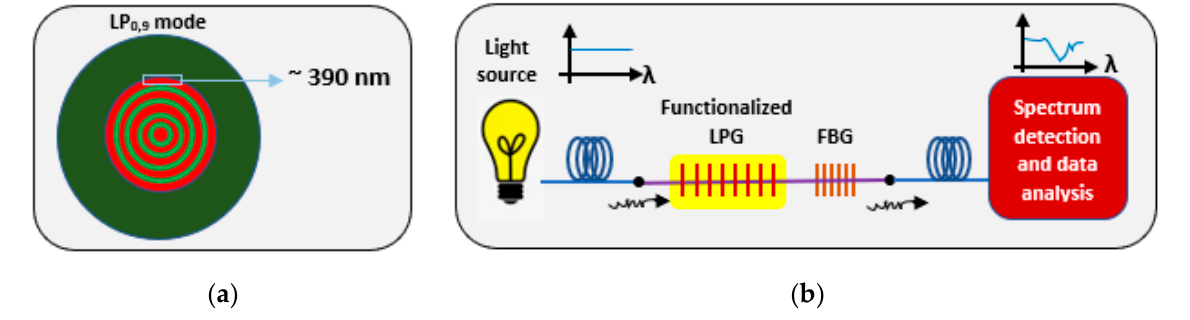
Figure 9. Schematic diagrams of ( a ) LP 0,9 mode and of ( b ) fiber optic hybrid grating setup via butt-coupling an FBG.